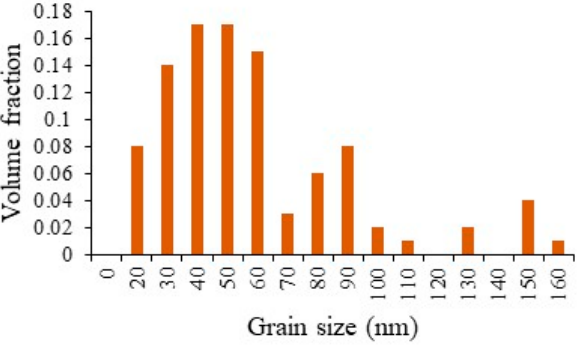
Figure 13. Grain size distribution of nanocrystalline copper used in the experimental test